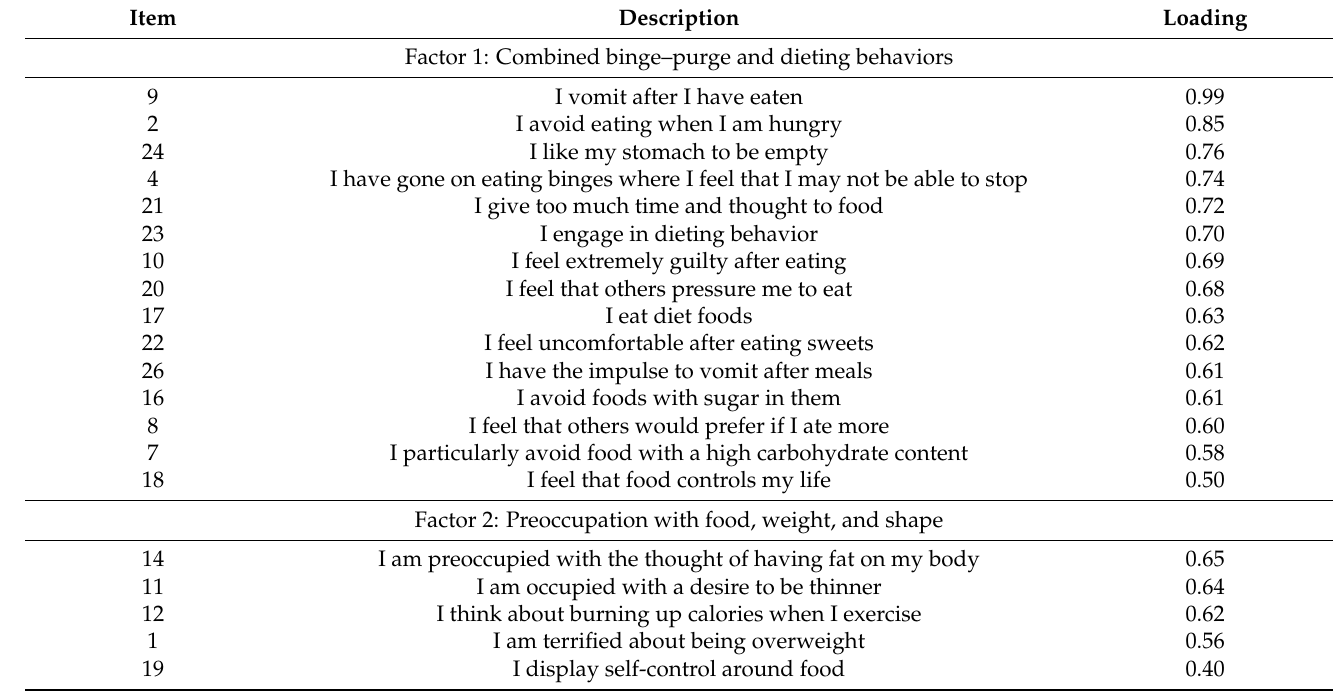
Table 4. EAT-26 factor loadings based on CFA in an Arab Christian nonclinical